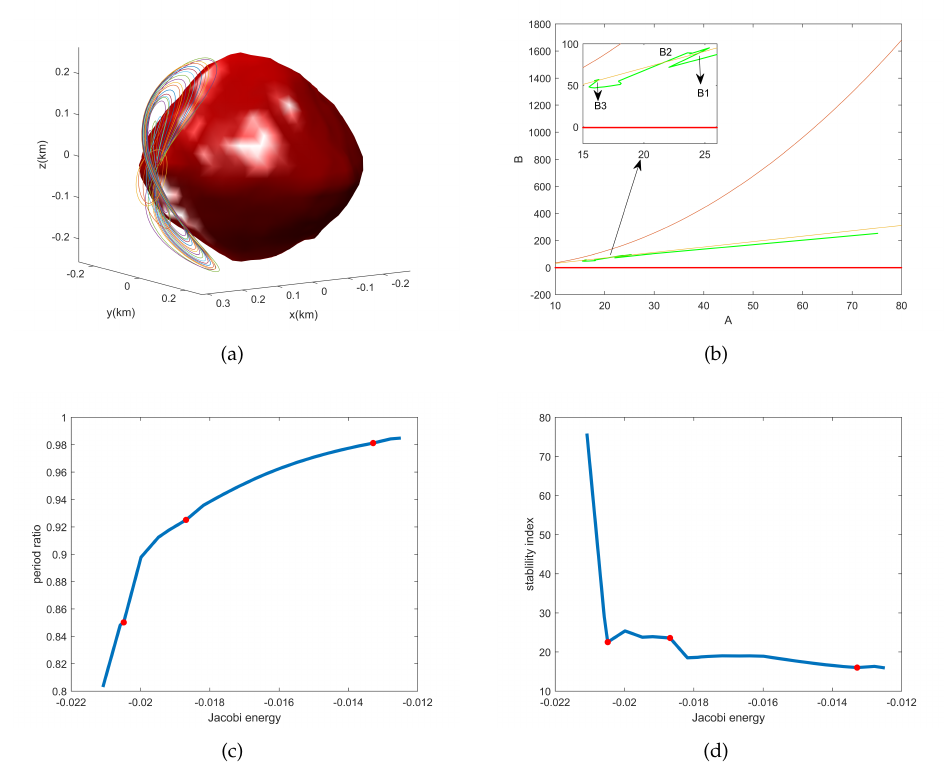
Figure 3. Periodic orbits during the continuation process of the vertical orbits family near 101955 Bennu: ( a ) sample of orbits in the rotating coordinate, ( b ) variation paths of (A, B) in the plane, ( c ) the variation of period ratios during continuation, ( d ) the variation of stability index with respect to the Jacobi energy. The unit for the Jacobi energy is m 2 · s − 2 . The three red points marked in ( c , d ) correspond to bifurcations and their Jacobi constants are − 0.0204, − 0.0187, −